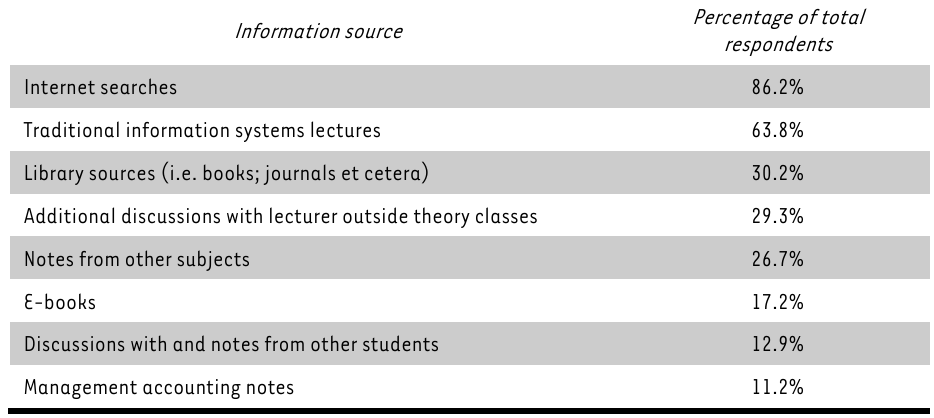
Information source